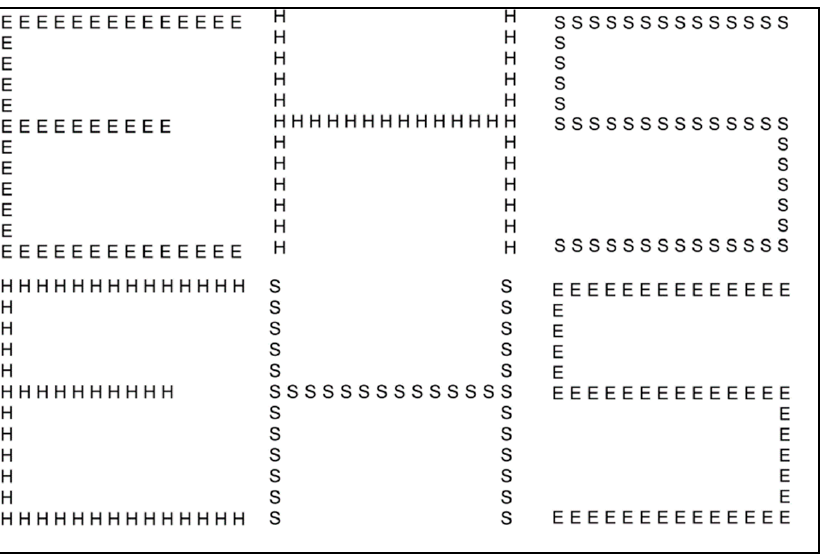
Figure 1. Hierarchical letters. Congruent stimuli are reported in the upper line, incongruent stimuli are reported in the lower line.